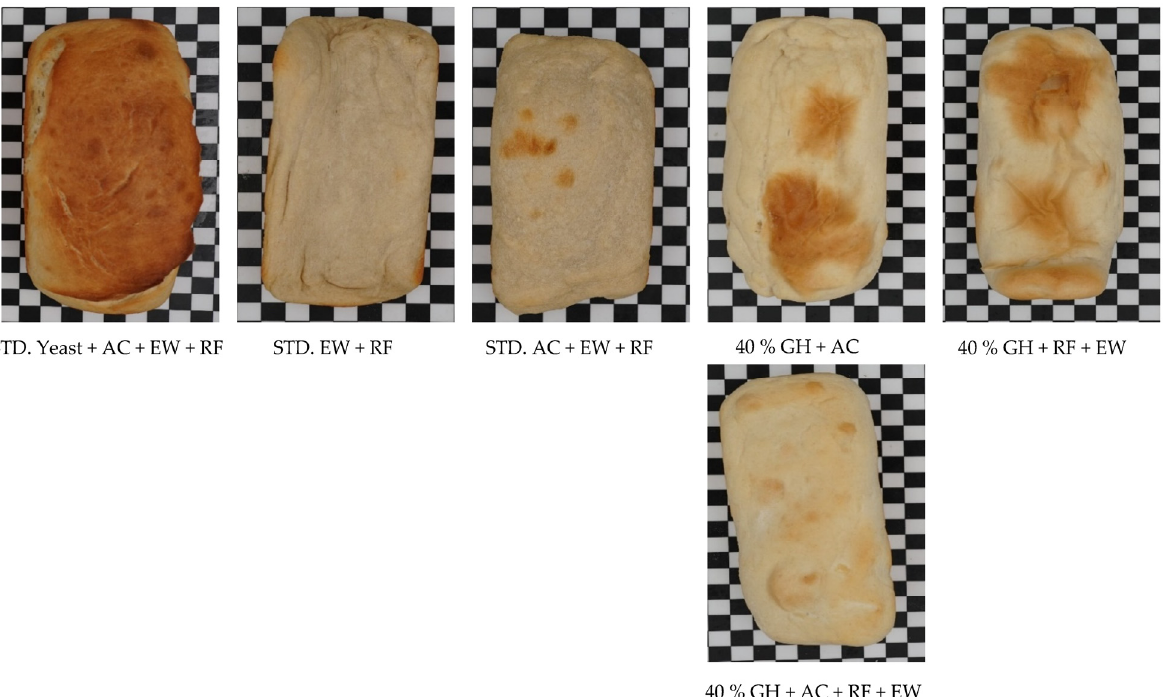
Figure 1. Pictures of GH bread (40% GH) with different gelling agents versus the standard bread. The effect of gelling agents along with GH improved the physical appearance of the bread.